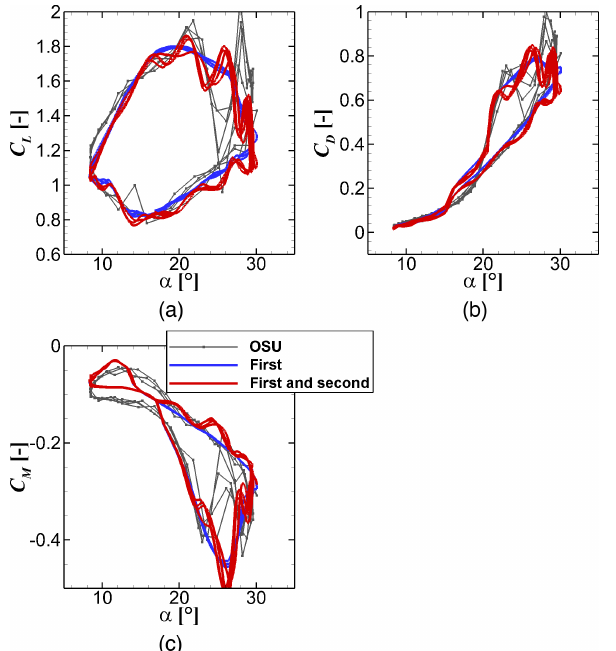
Figure 6. Airfoil response reconstruction in comparison with the experimental data for the S801 airfoil (Ramsay et al., 1996) apply- ing only the first-order correction and with inclusion of the second- order term. (a) Lift, (b) drag and (c) pitching